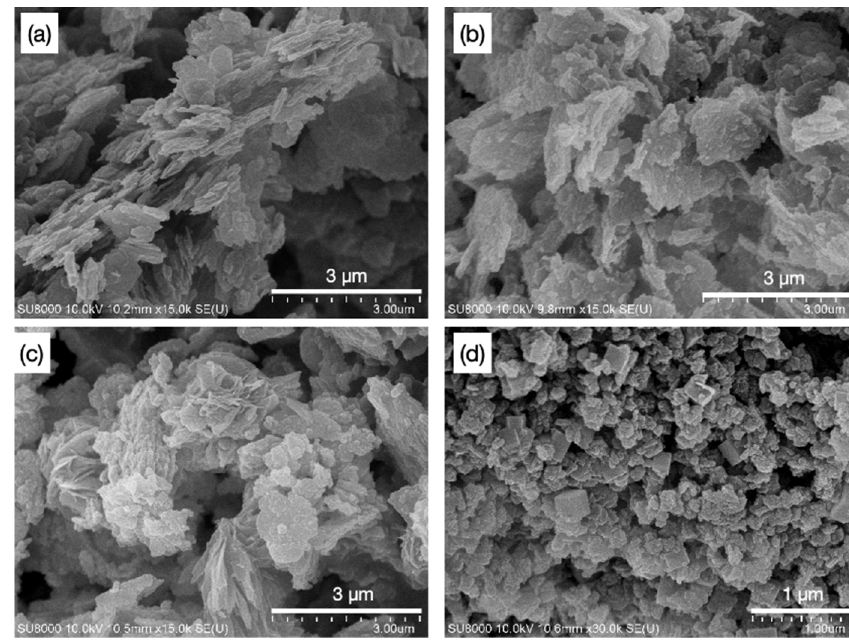
Figure 2. SEM images of ( a ) metakaolin, ( b ) BK1, ( c ) BK3, and ( d ) BK7.